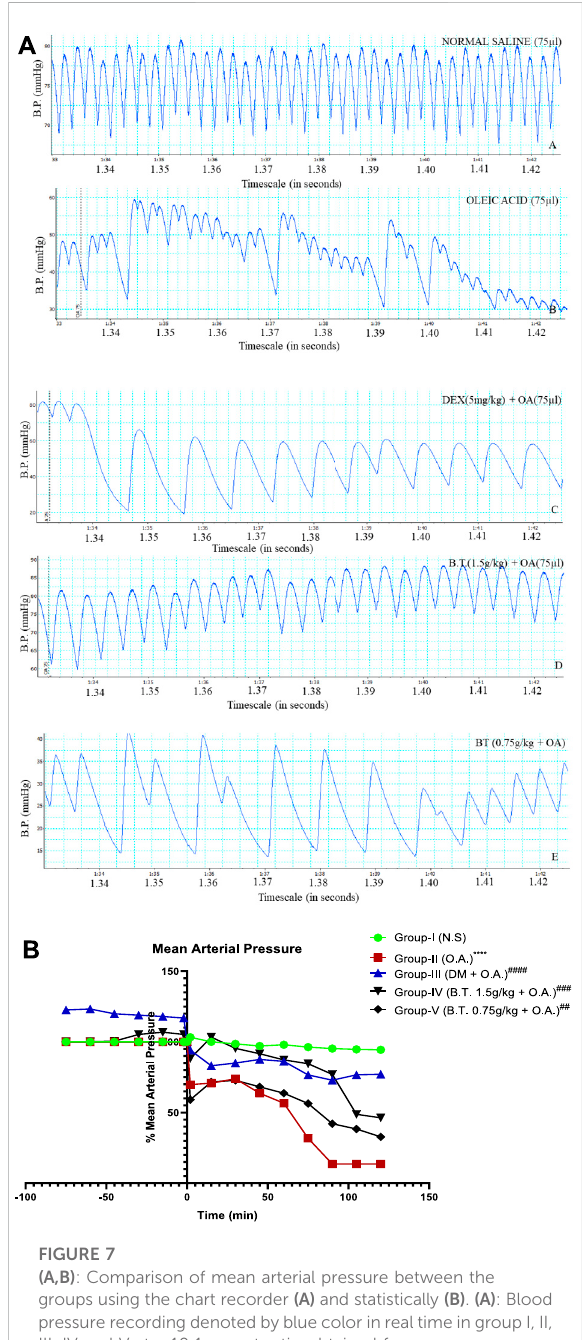
FIGURE 7 (A,B) : Comparison of mean arterial pressure between the groups using the chart recorder (A) and statistically (B) . (A) : Blood pressure recording denoted by blue color in real time in group I, II, III, IV and V at a 10:1 aspect ratio obtained from a computerized chart recorder where x -axis represents Blood pressure (mmHg) and y -axis represent timeline. Group I shows the basal value of BP (crest denoting systolic and the trough denotes diastolic), while a decrease in BP is prominent in group II. This was recti fi ed in treatment groups III and IV as near normal frequency canbeseenafterinstillationofoleicacid(denotedbyadottedline) instillation. (B) : Mean arterial pressure calculated from blood pressure as a percentage of initial at 0 min (denotes the time of instillation of oleic acid, except for group I). Results are expressed asmean±SD(n=6).Statisticalanalysiswascarriedoutusingone- sample T-test and Wilcoxon test where *, p < 0.05, ***, p < 0.001, ****, p < 0.0001 in comparison to group I and # ,p < 0.05, ###, p < 0.001 and #### , p < 0.0001 in comparison to group